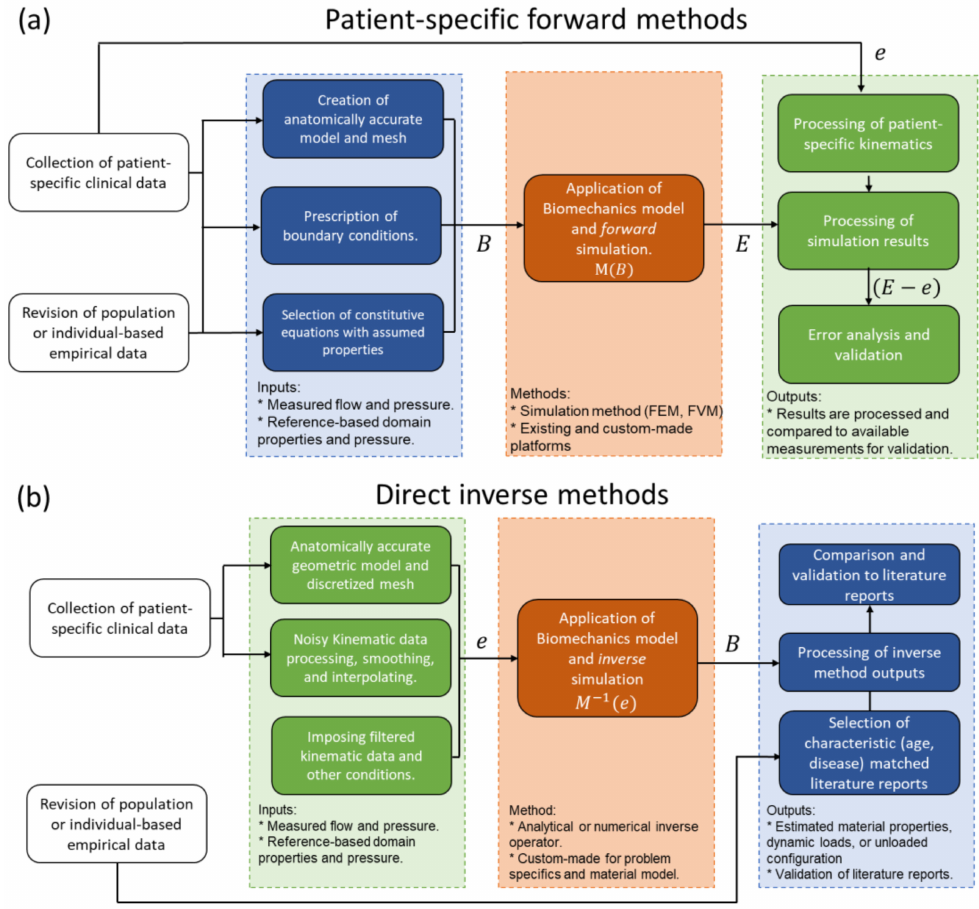
Figure 5. Data processing pipeline for patient-specific ( a ) forward problems and ( b ) direct inverse problems. Symbols, B : forward problem inputs, E : forward problem outputs, e : experimental